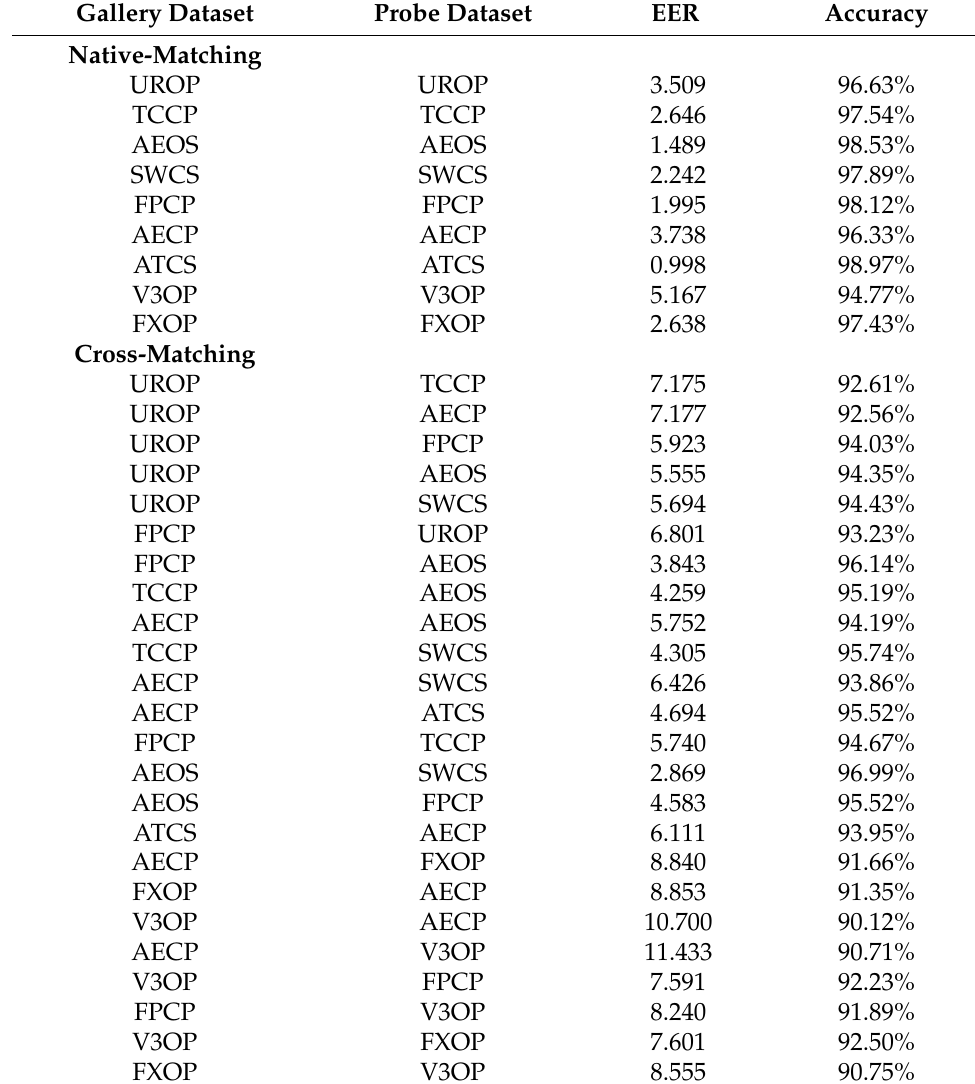
Figure 7. Maximum (blue) and minimum (pink) cross-EER on nine datasets of the FingerPass database. Table 2. The results of SiameseFinger on nine datasets from the FingerPass